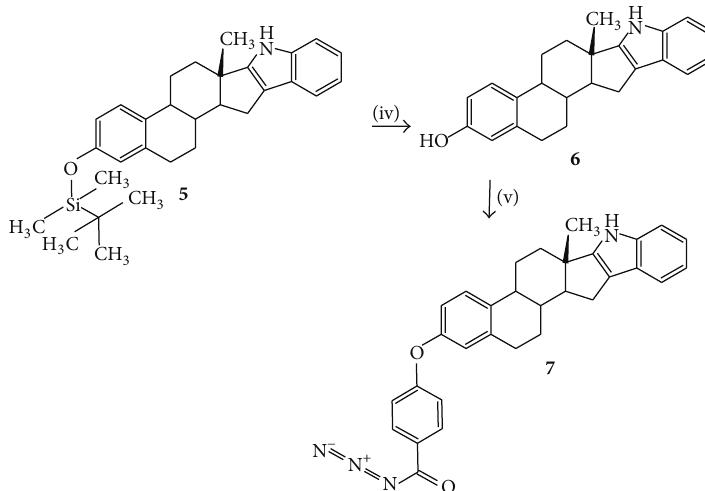
Figure 3: Synthesis of 3-(4-azidocarbonyl-phenoxy)-NH-indolo[2 󸀠 ,3 󸀠 :17,16]estra-1,3,5(10)-triene ( 7 ). The first stage was achieved by the reaction of 5 with hydrofluoric acid (iv) to form compound 6 (NH-indolo[2 󸀠 ,3 󸀠 :17,16]estra-1,3,5(10)trien-3-ol). In addition, 6 was made reacting with 𝑝 -nitrobenzoyl azide for synthesis of 7 . (v) = dimethyl sulfoxide.